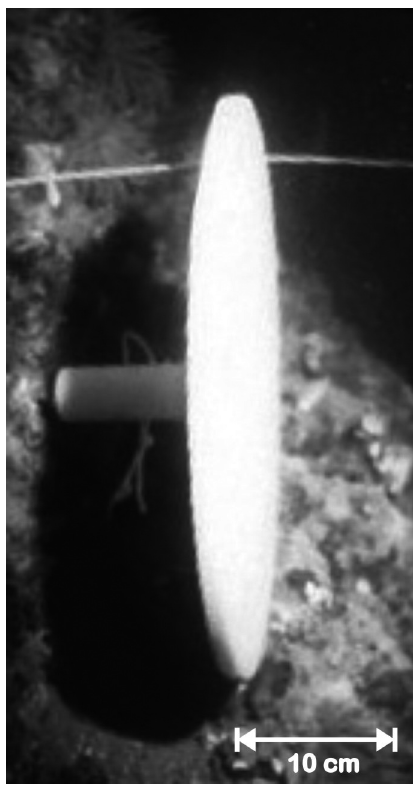
Fig . 1. – experimental polyethylene panel installed at 17 m water